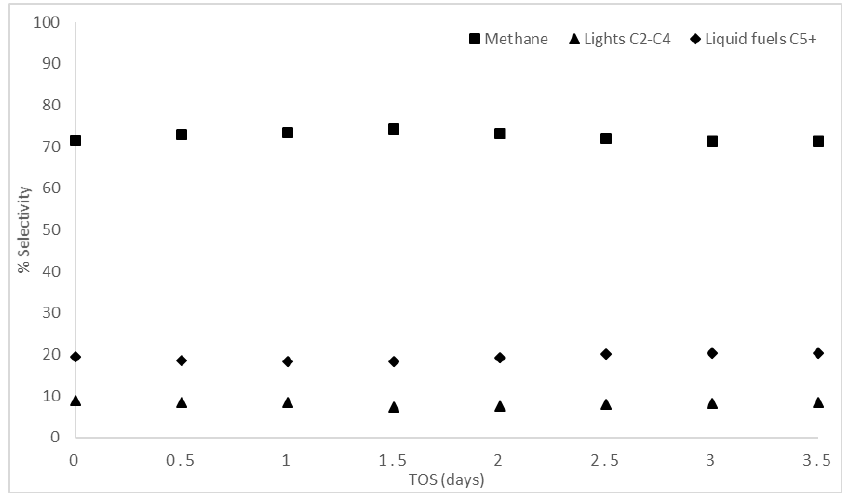
Figure 3. R1 product selectivity (refer to Tables 1 and 2 for reaction details).